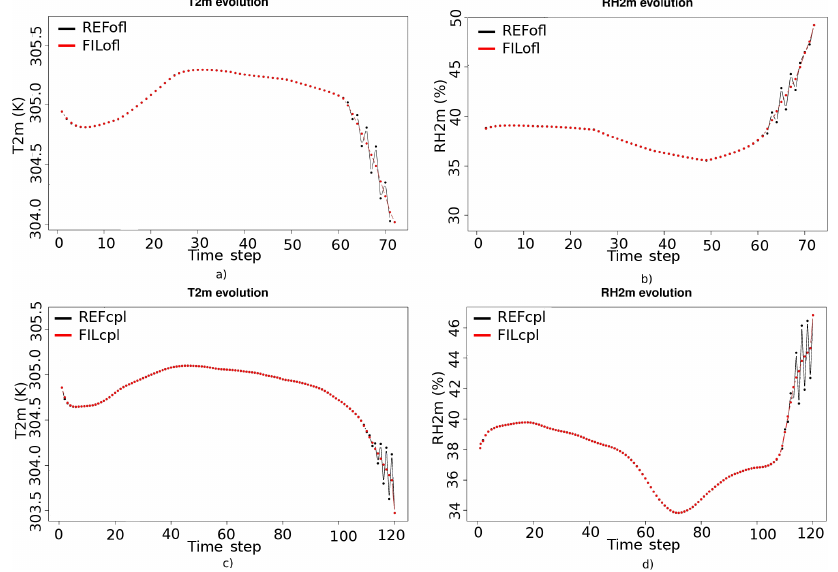
Figure 7. Evolution of T 2m (left) and RH 2m (right) at location A for the offline (top) and coupled (bottom) reference runs (REF, black) and the filtered run (FIL,